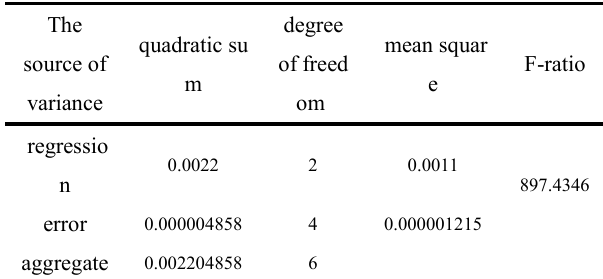
Figure 2 lamda and RSS changes in Box-cox transformation At this time, the regression model selected according to this parameter can find the following results: